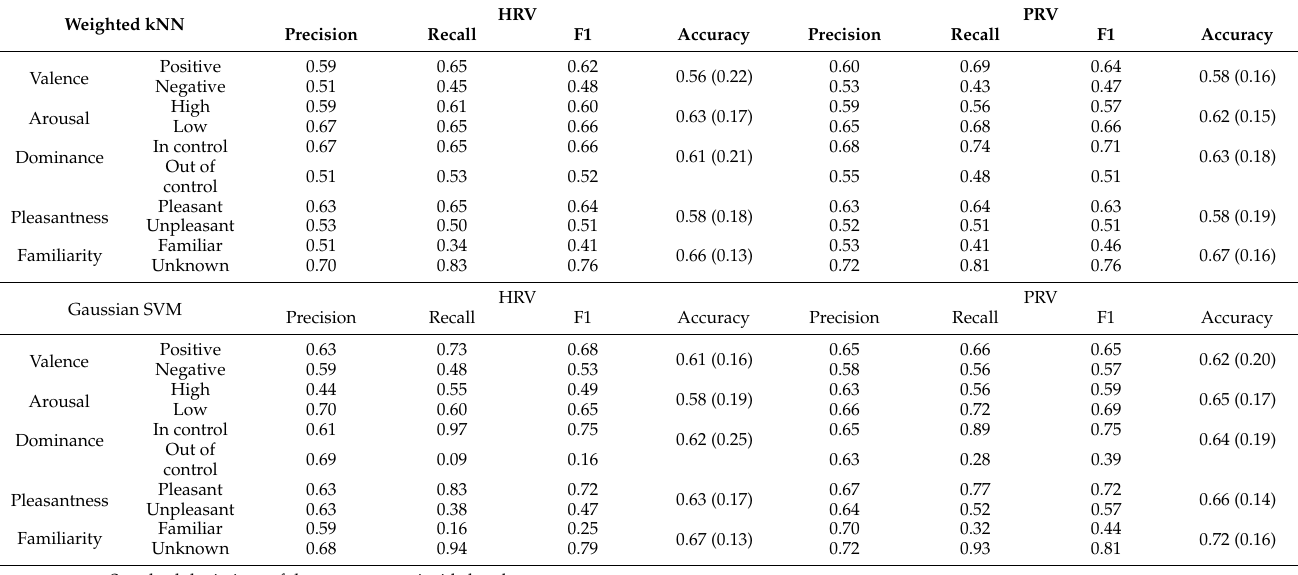
Table 6. Classification metrics: HRV versus PRV